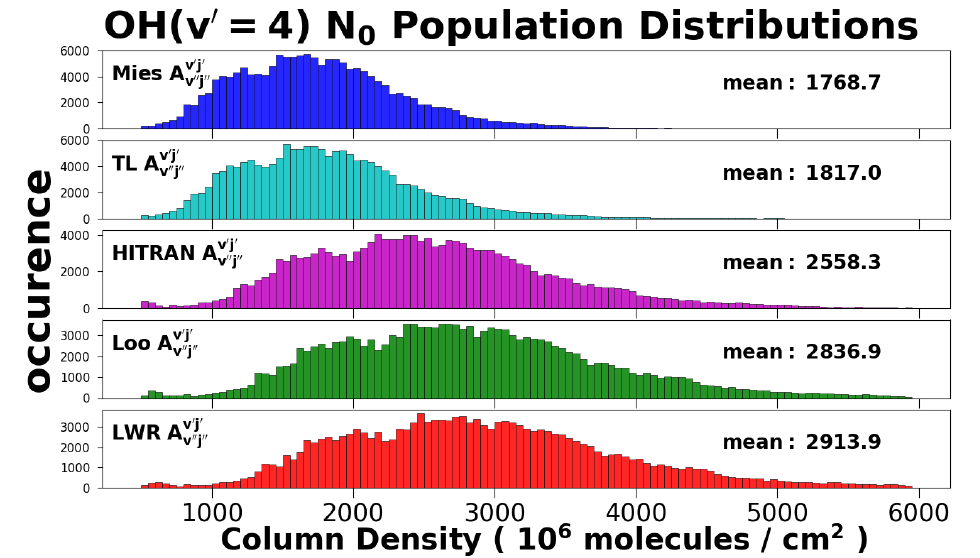
Figure 3. The distributions of N 0 population versus Einstein A coefficients for the APOGEE data